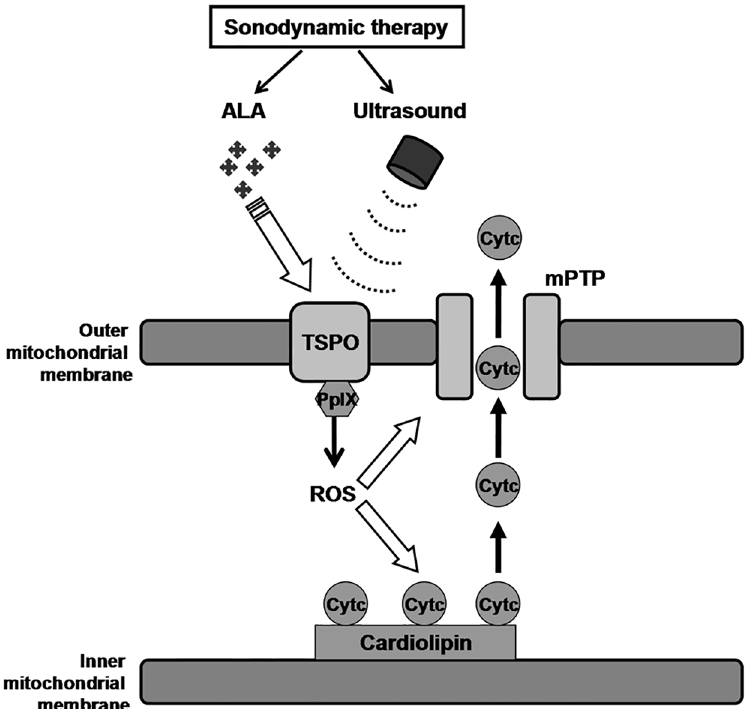
Fig 8. Schematic summary illustrating cytochrome c (Cytc) release due to reactive oxygen species (ROS) generation following activation of 5-aminolevulinic acid derived protoporphyrin IX (ALA-PpIX) binding to the 18 kDa mitochondrial translocator protein (TSPO) and subsequent opening of mitochondrial permeability transition pore (mPTP).